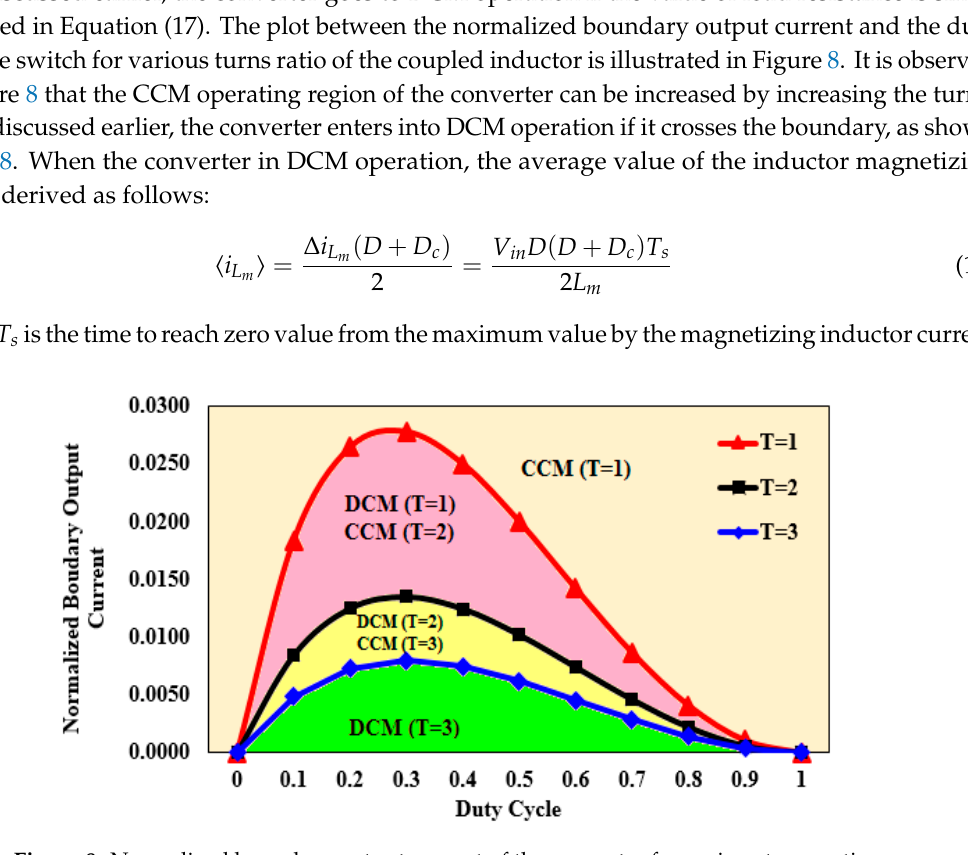
Figure 8. Normalized boundary output current of the converter for various turns ratio.